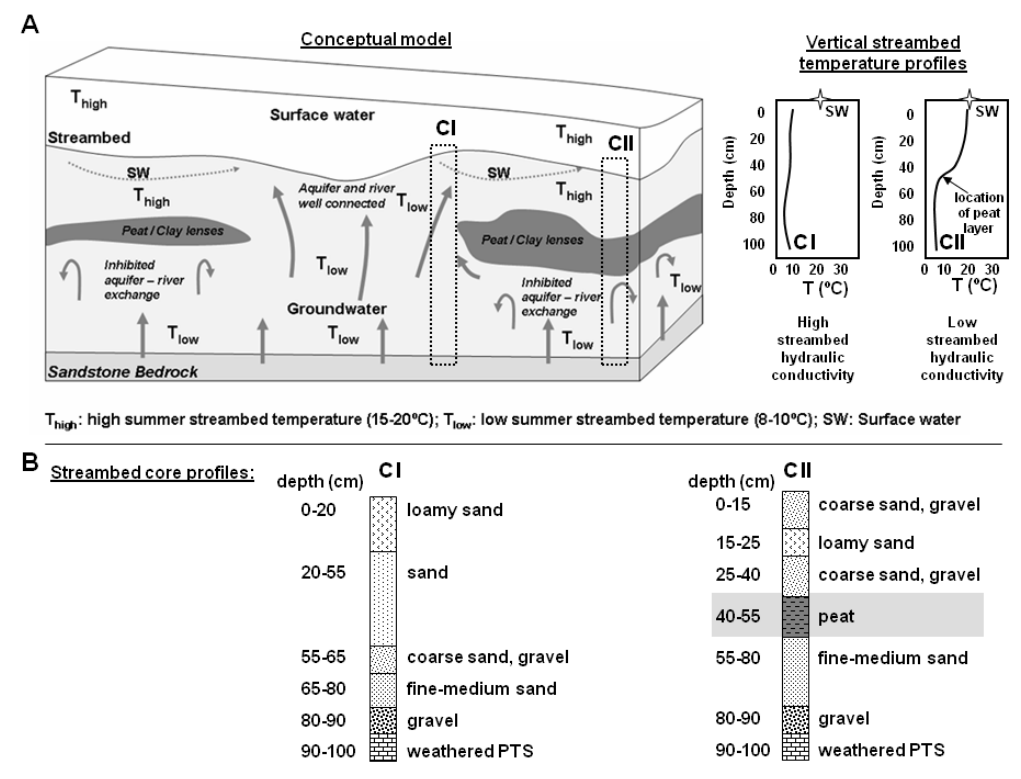
Fig. 2. (A) : conceptual model of streambed hydrofacies controlling groundwater up-welling in a typical lowland river including their effect on heat transport at the aquifer–river interface (the star indicates the temperature of the surface water). (B) : core logs of example streambed cores CI and CII (for sampling locations see Fig.